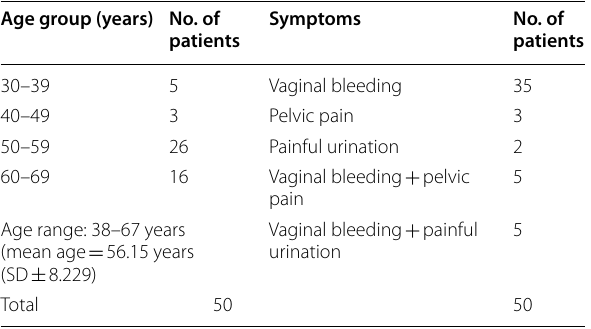
Table 1 Age distribution and clinical presentation of the studied 50 cases